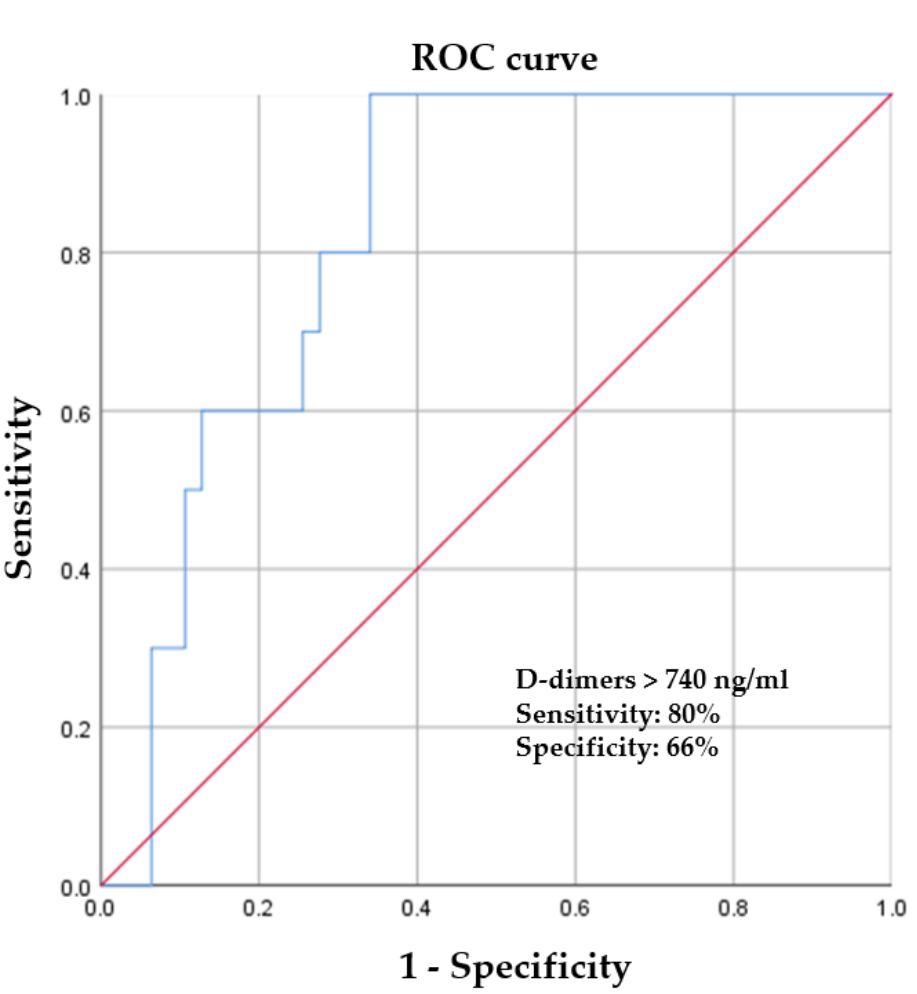
Figure 1. Receiver operating characteristic curve of D-dimers in predicting a higher risk of coronary thrombosis for patients with myocardial infarction and SARS-CoV-2 infection.